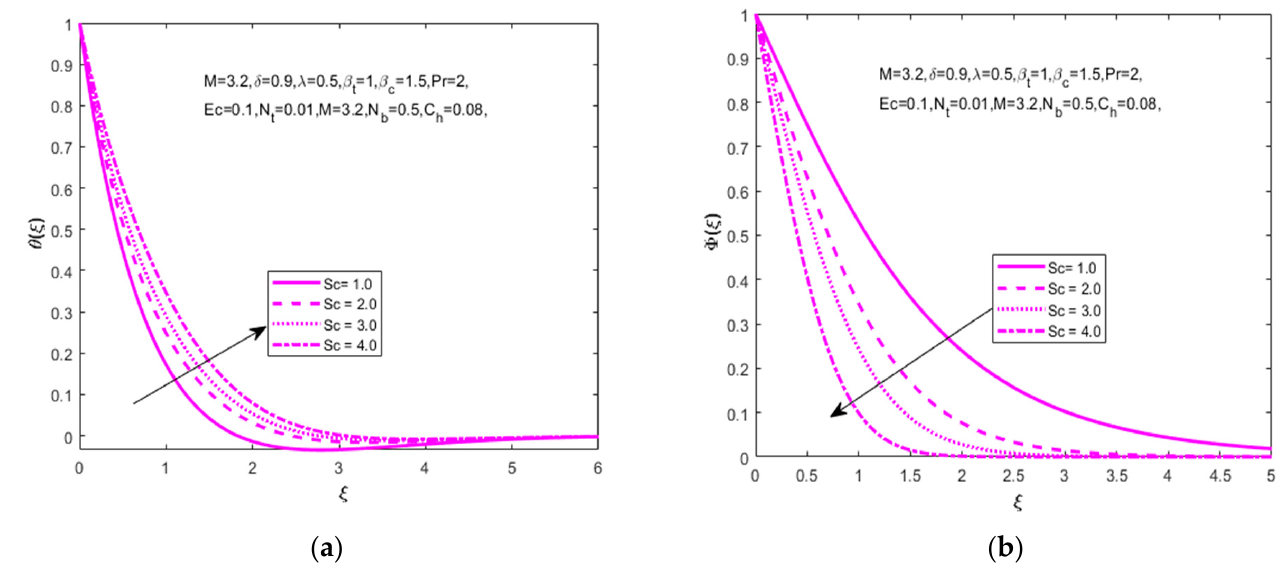
Figure 7. Impact of Schmidt number Sc on ( a ) temperature θ ( ξ ) and ( b ) concentration Φ ( ξ ) , respectively. The temperature distribution described in Figure 8b shows that the greatest values of the Prandtl number decrease the temperature distribution ( θ ( ξ )) due to the inverse properties of the thermal and Prandtl numbers. Figure 9a,b signifies the influence of the chemical reaction parameter. The important note is that the enhanced homogeneous chemi- cal reaction parameter enhances the velocity ( F (cid:48) ( ξ )) and concentration ( Φ ( ξ )) distributions.